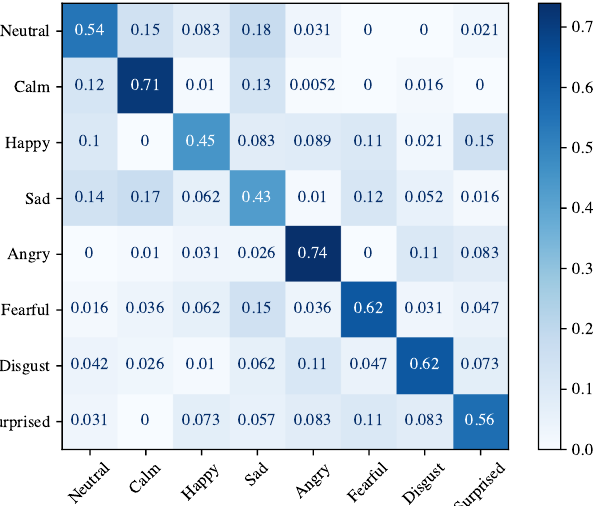
Figure 11. Confusion matrix for speaker-independent emotion